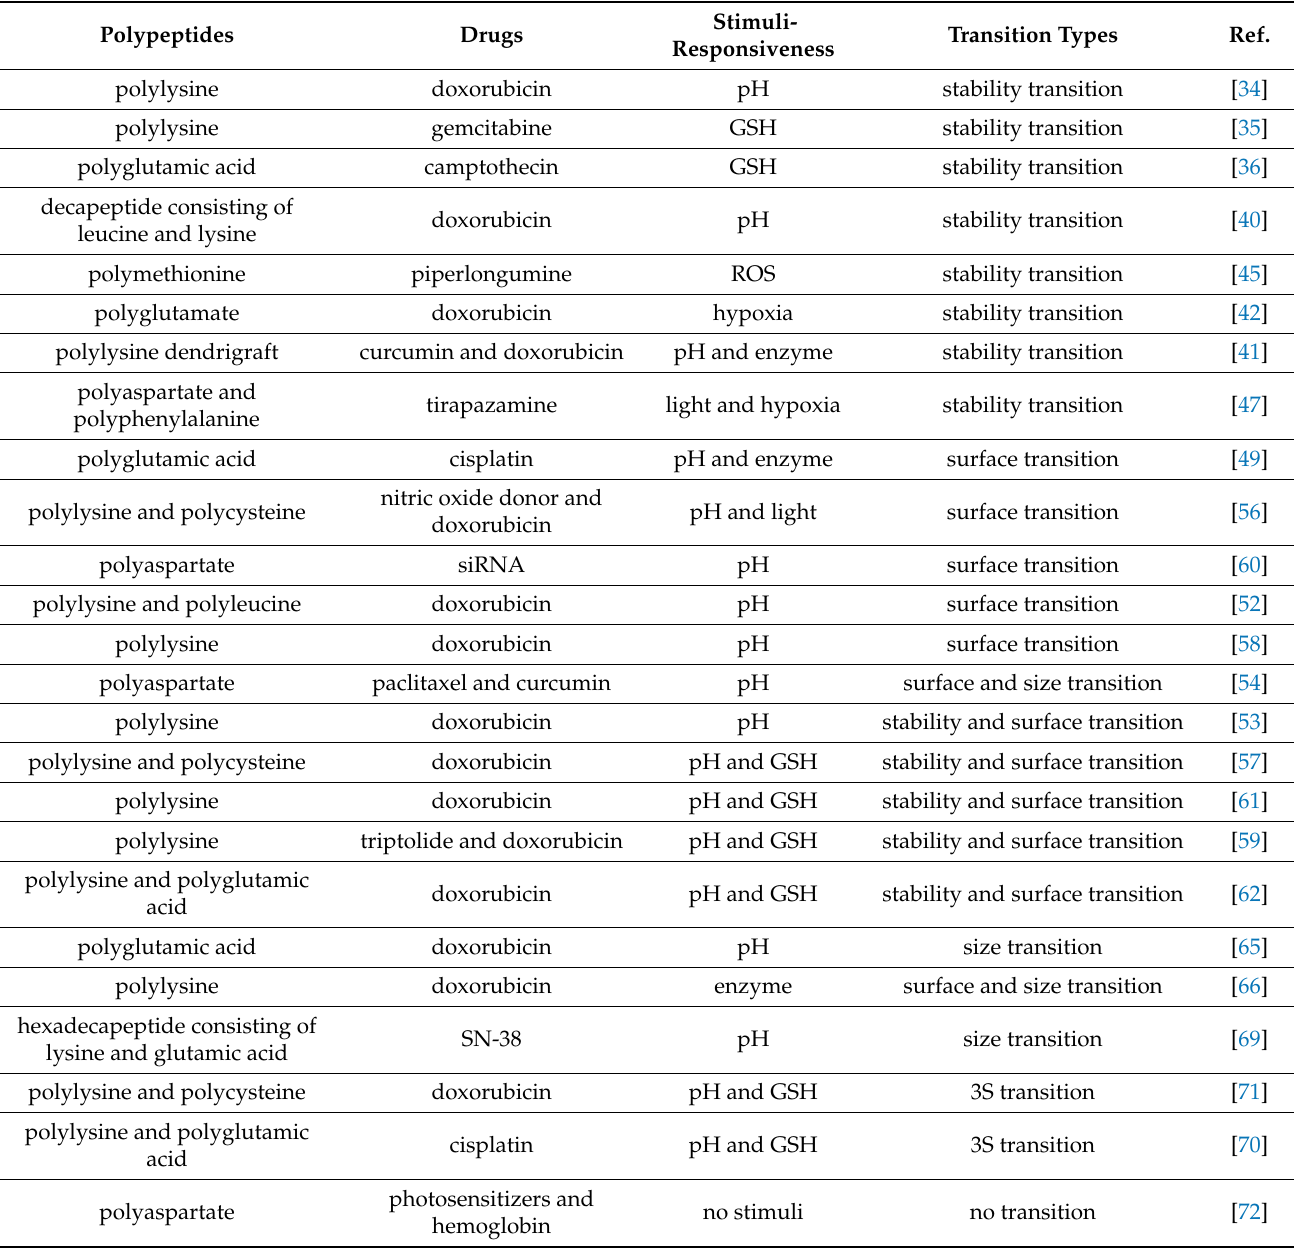
Table 2. Examples of different transition polypeptide systems for anti-tumor drug